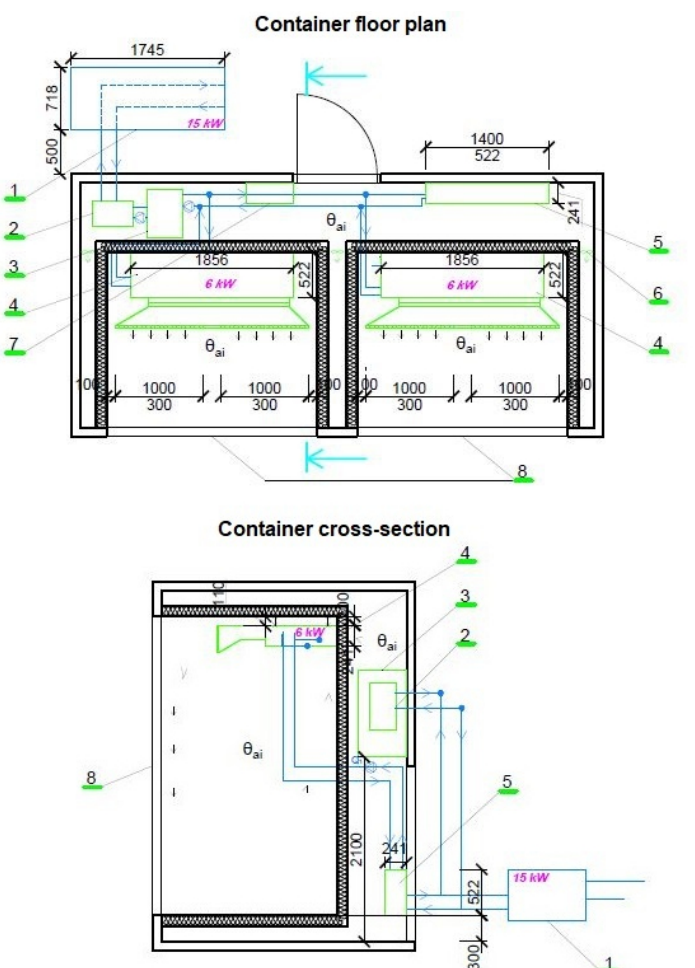
Figure 2. Construction scheme of technological equipment of an experimental test cells Twin Rooms. 1 –